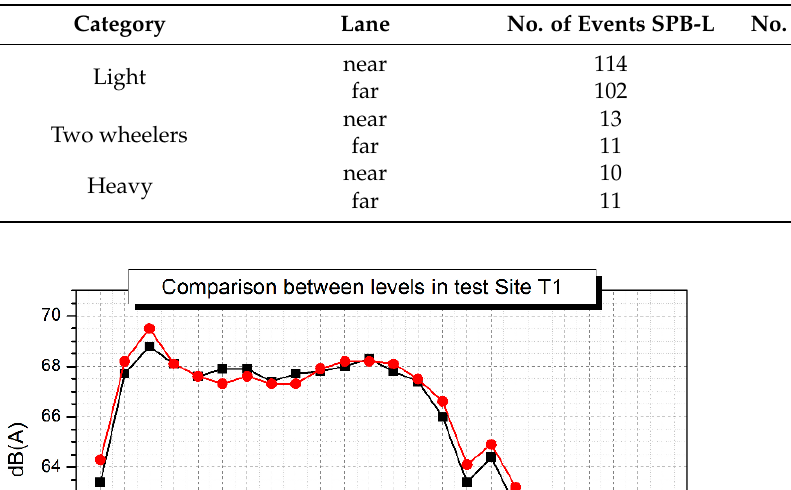
Table 6. Number of analyzed pass-bys in T1 (night dataset and SPB-L).